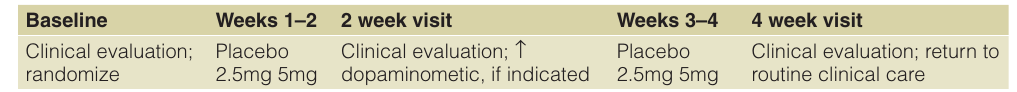
Table 1. Summary of final study